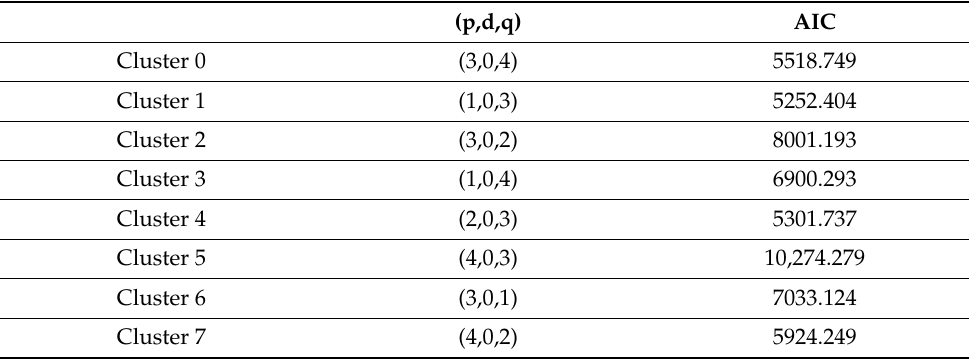
Figure 16. Cluster Group Membership based on load values. Table 7. Akaike Information Criteria and Best ARIMA (p,d,q) for Each